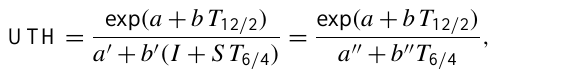
Fig. 2. Relative error incurred to the prefactor (1 /P H ) of the UTH i calculation via errors in the estimated channel 6 brightness temper- ature, that is due to the regression with T 6 / 4 . Measurement errors of T 6 / 4 are not taken into account for this calculation. The relative error is P H ∆(1 /P H ) = − [( b 0 T 6 ) / ( a 0 + b 0 T 6 )] · [(∆ T 6 ) /T 6 ] . The red line represents the true values (0% error), the other lines show the relative errors of 1 /P H for ± 0 . 05 % (outer lines in green and light blue) and for ± 0 . 03 % error in T 6 (inner dark blue and violet curves).